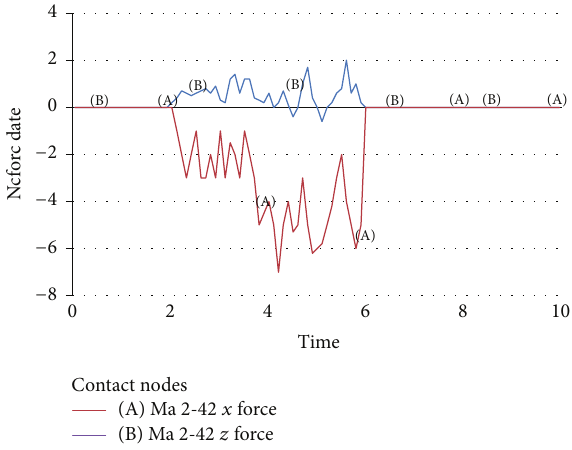
Figure 8: Distributions of the vertical and shearing force in block element Ω A in consideration of the breakaway conditions ( 𝑧 -axis: vertical force, 𝑥 -axis: shearing force).